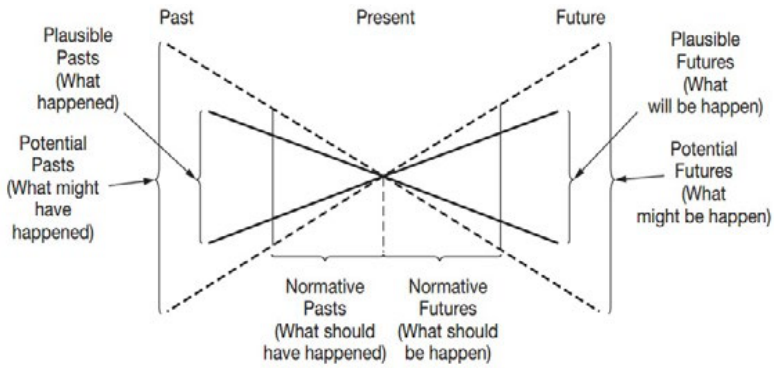
Fig.1. Three types of societal futures: potential, plausible, and normative (Dunn, 2014, 121)